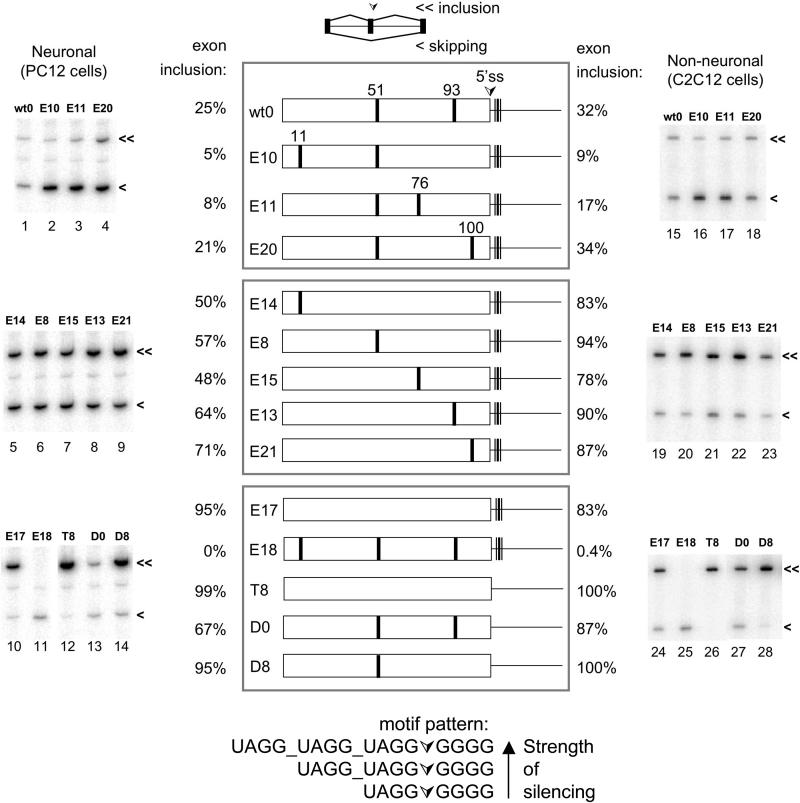
Effect of Number and Position of CI Cassette Exon Splicing Silencer MotifsSplicing reporters were constructed with variations in the number and position of UAGG and/or
GGGG motifs. Three sets of schematics (boxed at center) illustrate the CI cassette exon and adjacent 5′ splice site region with positions of exonic UAGG (black vertical bars) and 5′ splice site
GGGG (grey vertical stripe) motifs. Splicing reporter names are indicated at left. Vertical arrowhead indicates 5′ splice site. Each splicing reporter was generated by site-directed mutagenesis from parent plasmid wt0. Natural UAGG positions 51 and 93 represent the starting position of the motif relative to the first base of the exon. Engineered UAGG positions 11, 76, and 100 are also indicated (see schematic in center box at top). Sequence changes of the mutations are underscored: 11, GUGG→UAGG; 51, UAGG→AUGG; 76, CCAG→UAGG; 93, UAGG→GUGG; 100, UCCAA→UAGGC. Representative splicing patterns in PC12 cells (left gel panels) and C2C12 cells (right gel panels) are shown together with average percent exon inclusion values. The correlation between motif pattern and strength of splicing silencing is summarized (bottom). Exon-included (double arrowheads) and exon-skipped (single arrowheads) products are indicated.